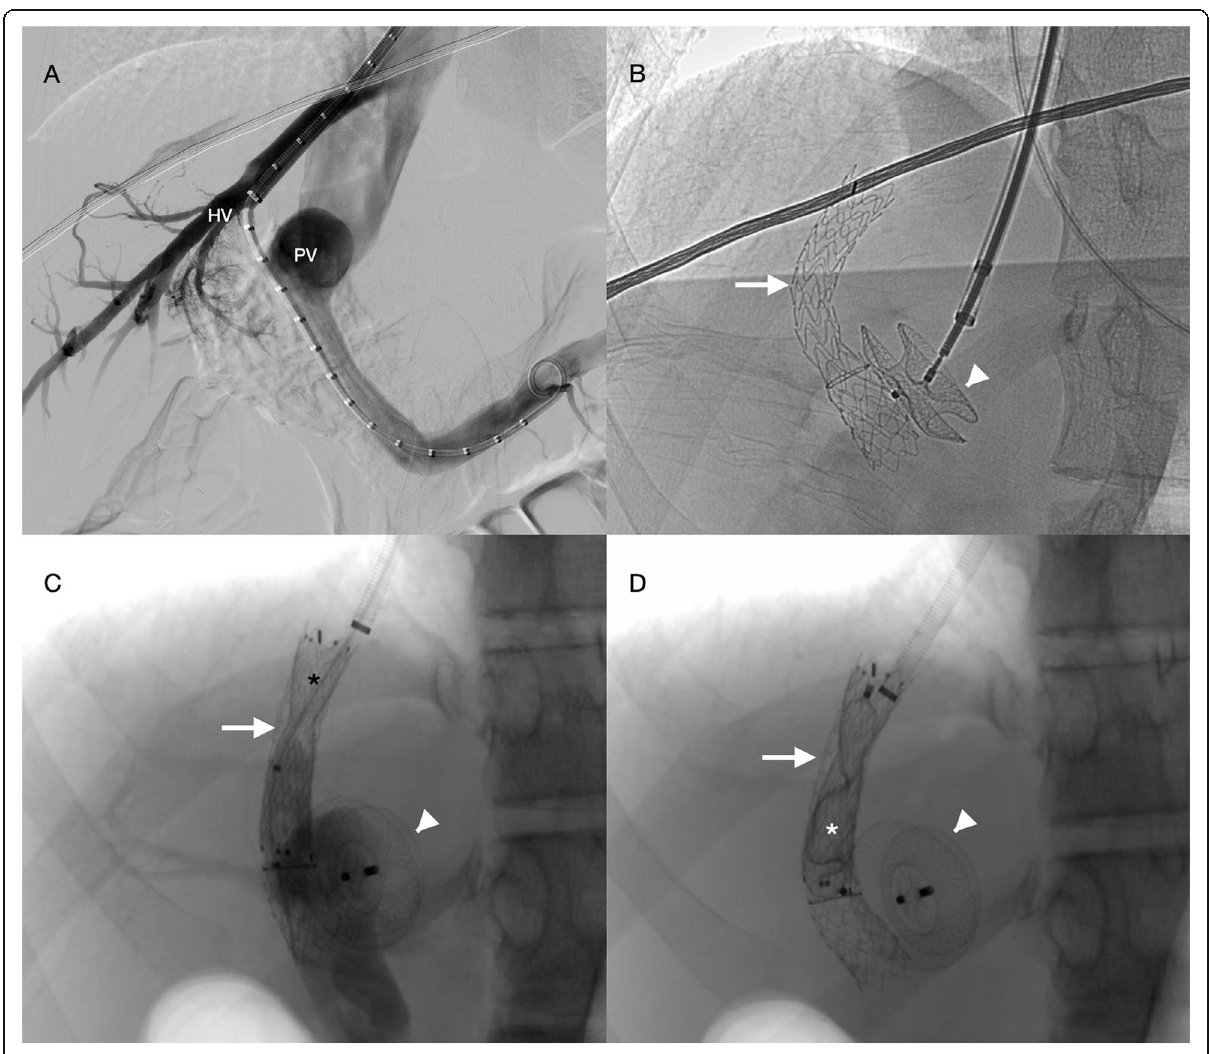
Fig. 2 Multistage closure of a type II congenital extrahepatic portosystemic shunt. A ) and B ) In the first procedure an atrial septal defect plug (white arrowhead) was deployed in the shunt after a transjugular intrahepatic portosystemic shunt creation (white arrow) between the middle hepatic vein (HV) and the right portal vein (PV). C ) During the second procedure, a balloon occlusion portal venography was performed after the deployment of a flow restrictor stent (black asterisk). There was an 8 mmHg portal pressure increase to 14 mmHg. D ) As portal pressure remained low, the TIPS was ultimately closed using a vascular plug (white